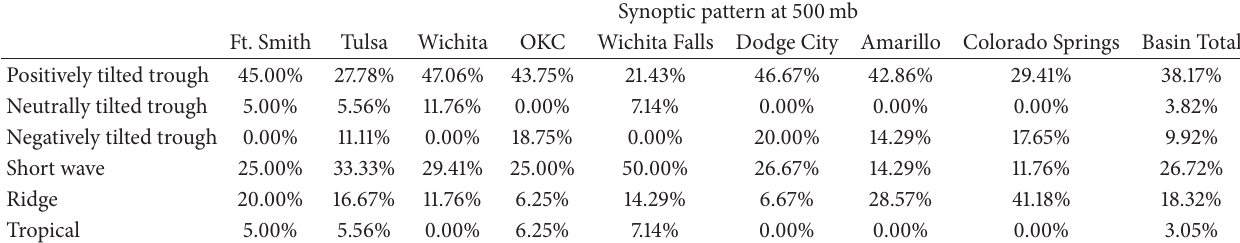
Table 4: Percentage of cases per synoptic pattern at 500 mb by location.